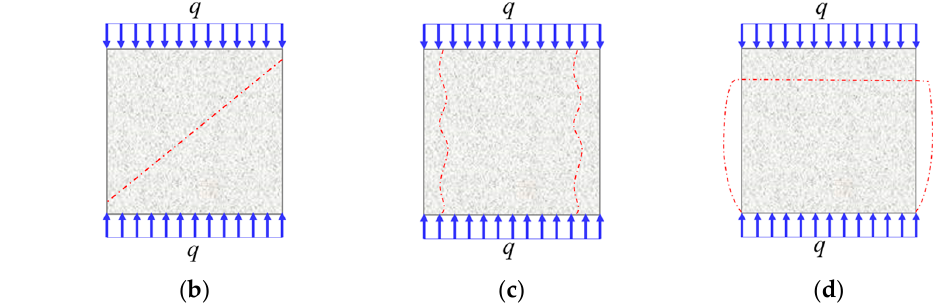
Energies 2023 , 16 , x FOR PEER REVIEW 13 of 17 ( a ) ( b ) ( c ) Figure 10. Fracture evolution characteristics of RBB samples: ( a ) Samples without FA and SF; ( b ) Samples containing FA and without SF; ( c ) Samples without FA and containing SF.